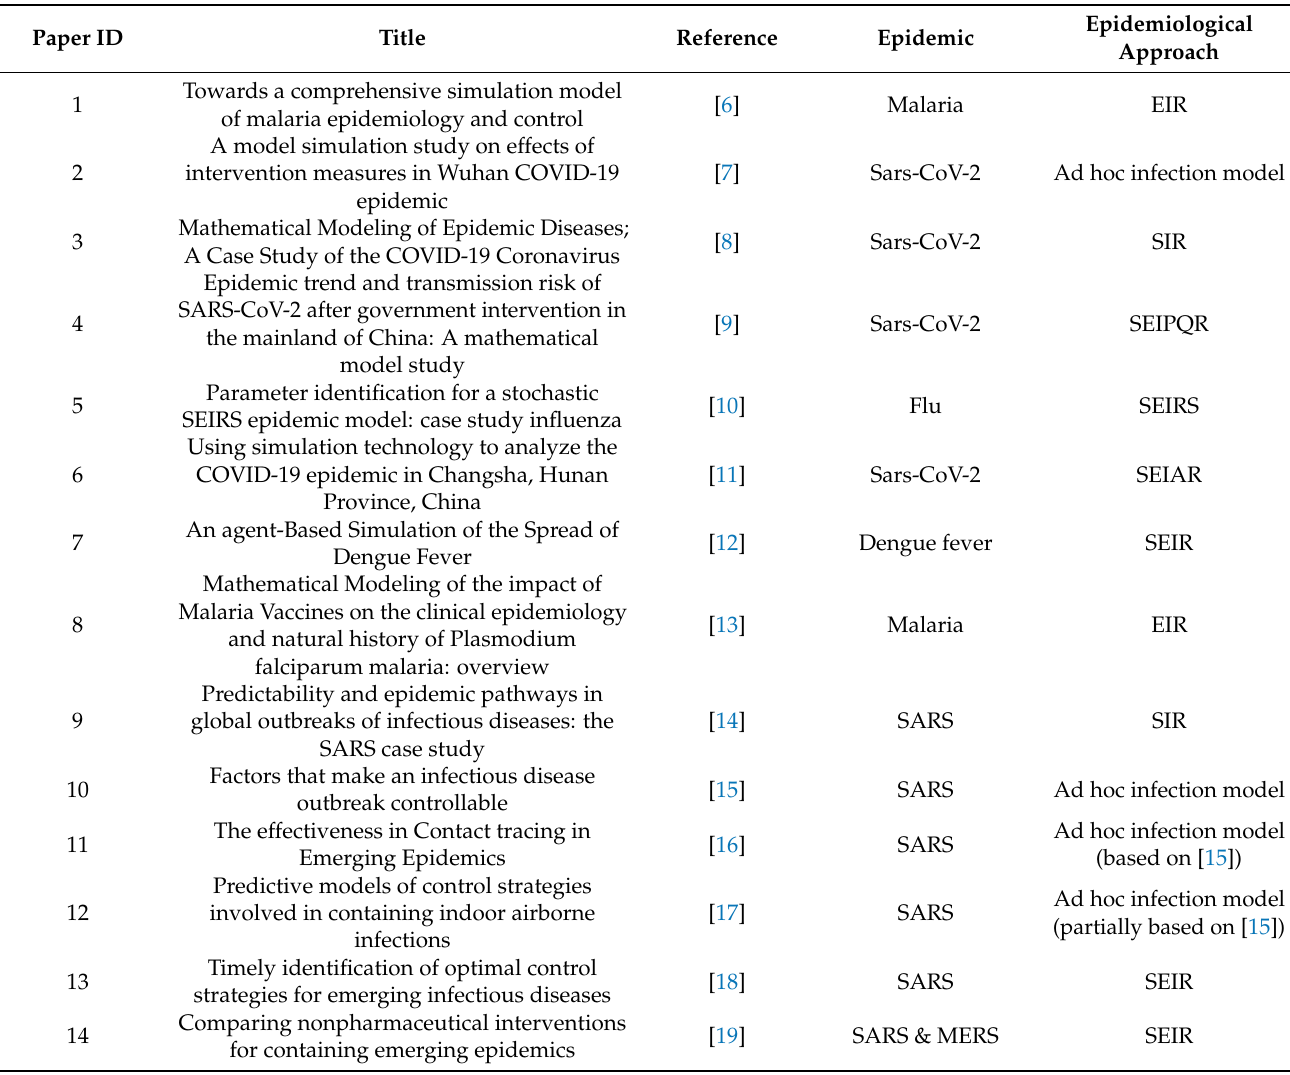
Table 1. Epidemiological studies